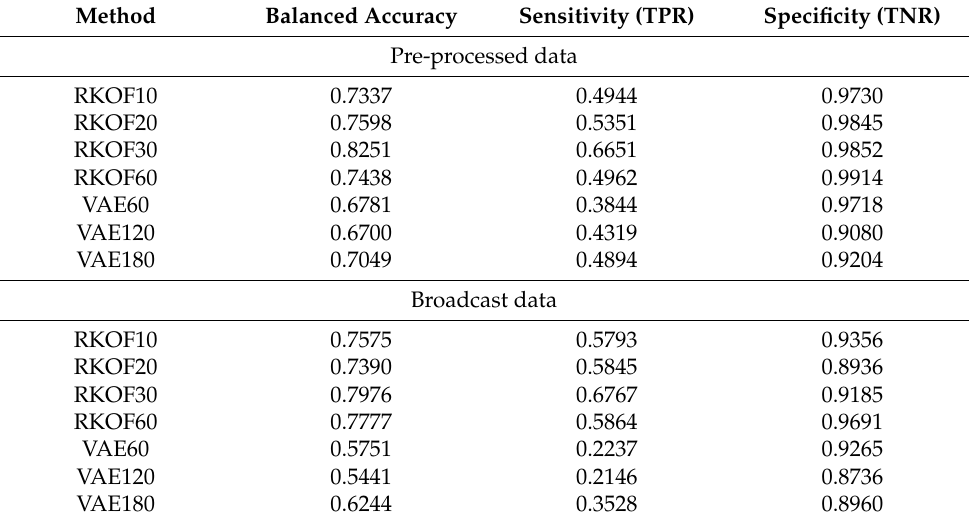
Table 2. Classification performance measures for several models of anomaly